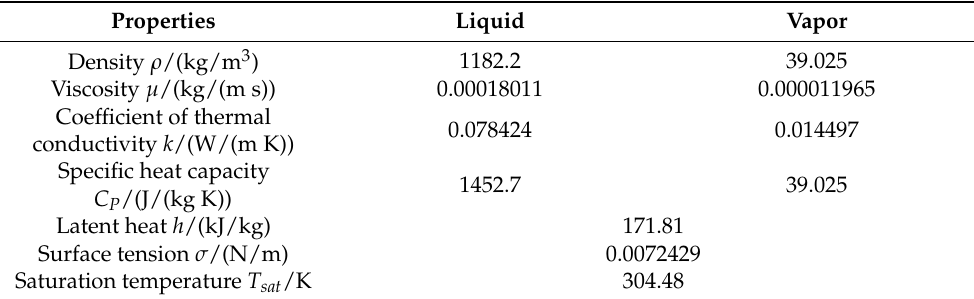
Table 2. Properties of